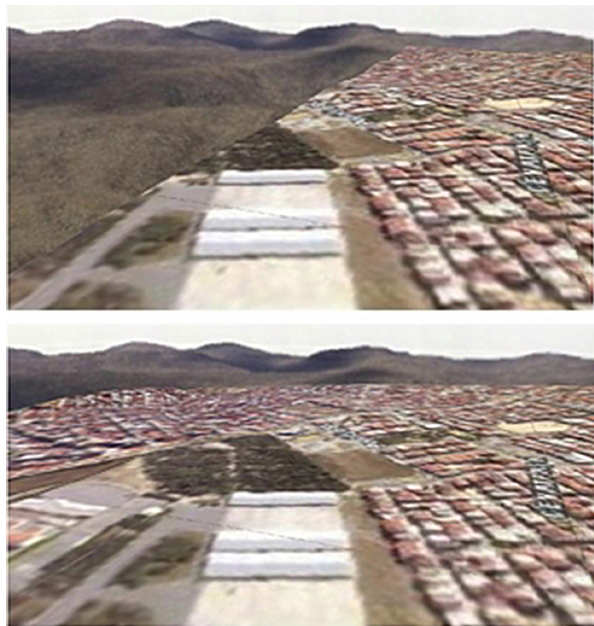
Figure 20. Reconstruction of the model in the direction of the movement upon reaching the boundary of the surface at a specific